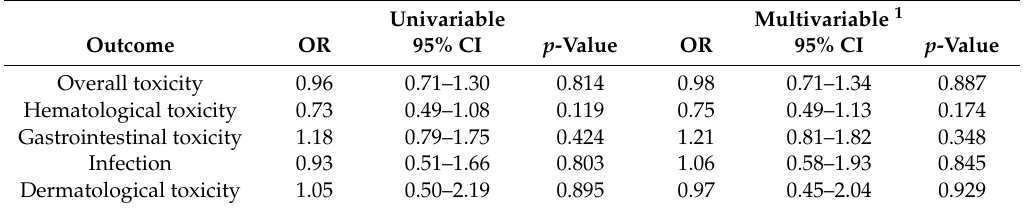
Table 4. Toxicity association with number of TSER-repeats. Associations were assessed in the 621 patients carrying only two or three repeat-element alleles. p -values from logistic regression models; 1 adjusted for cis-and carboplatin co-administration, sex, age, and DPYD -risk variants. Univariable Multivariable 1 Outcome OR 95% CI p -Value